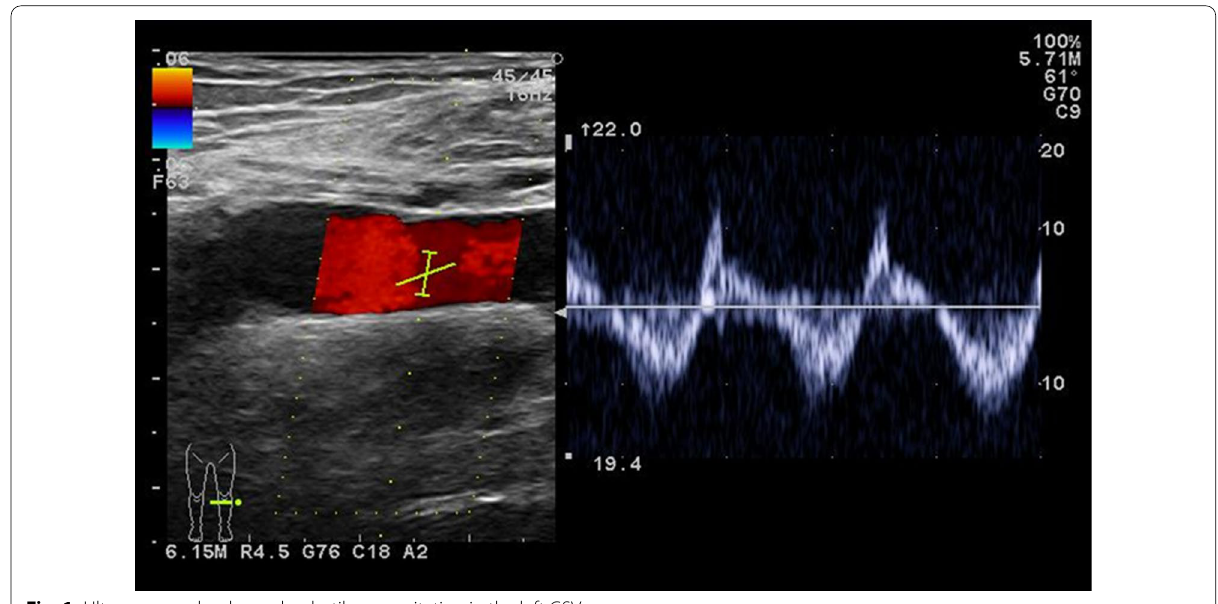
Fig. 1 Ultrasonography showed pulsatile regurgitation in the left